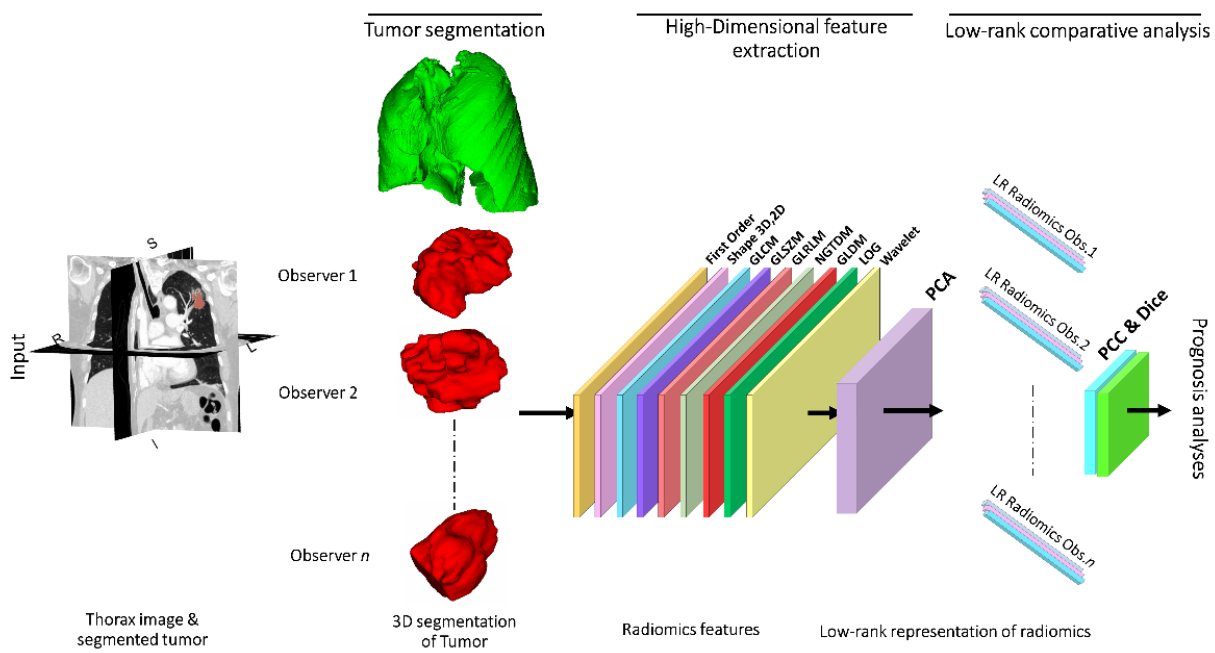
Figure 1. Workflow of the approach. The NSCLC tumor is segmented from the original CT images by four segmenters ( n = 4) with different backgrounds, yielding radiomics features and tumor masks as inputs. Next, PCA categorizes features based on their maximum variance in radiomics. For every group, three principal components of feature sets are selected and used for correlative analysis and prediction of survival.